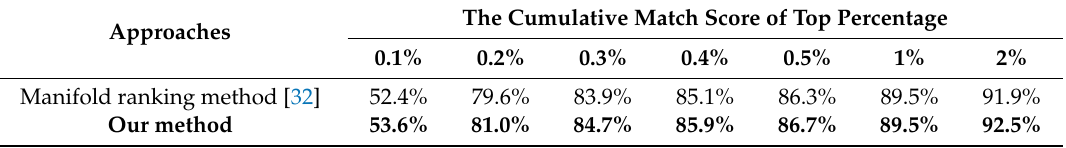
Table 2. Comparison with the traditional manifold ranking method.